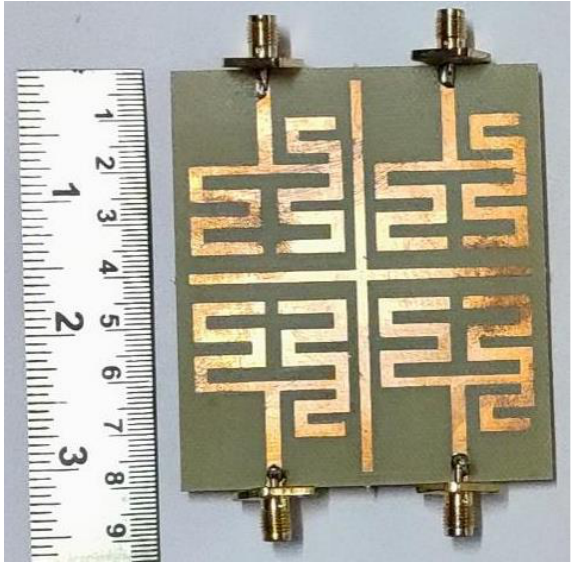
Figure 10. Image of fabricated four elements MIMO with parasitic cross microstrip line structure.